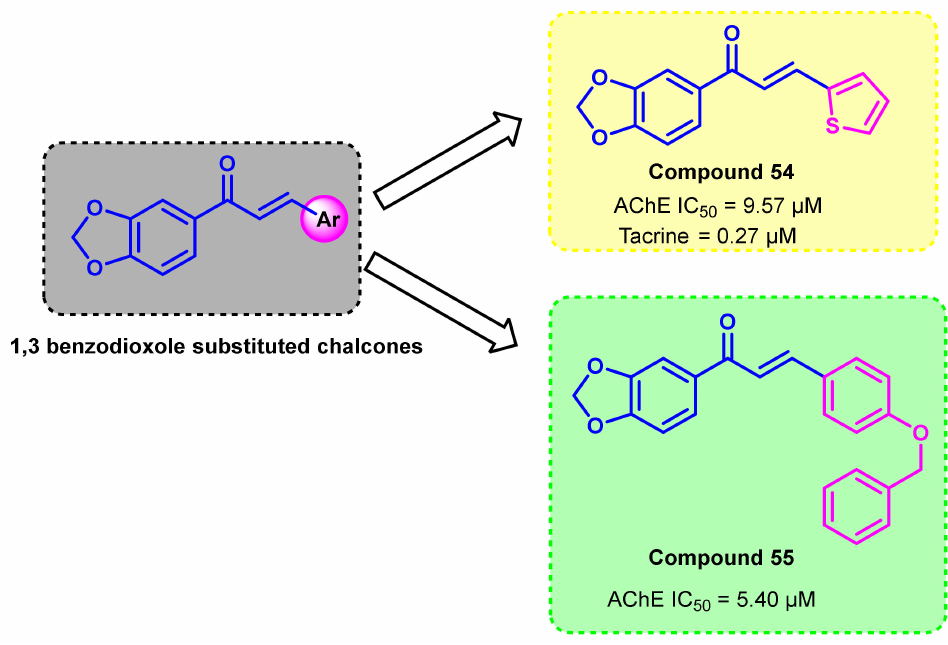
Figure 45. Chemical structures of benzodioxole chalcone